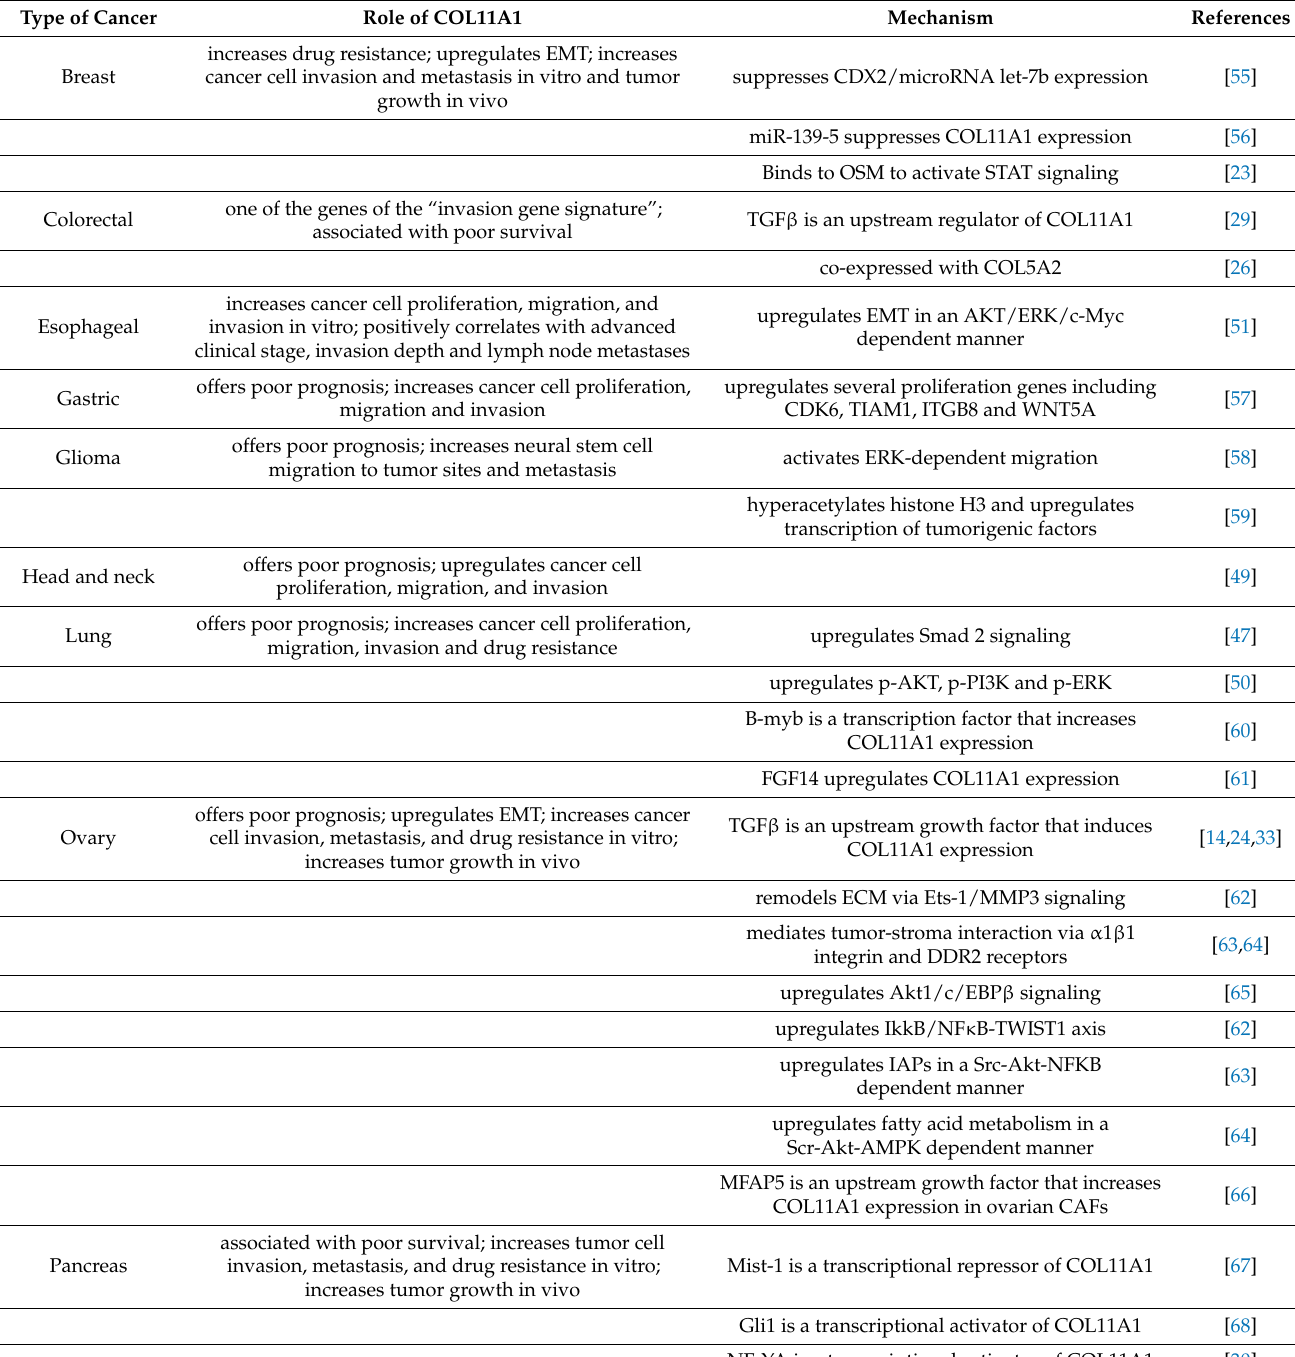
Table 1. COL11A1 expression and functions in different